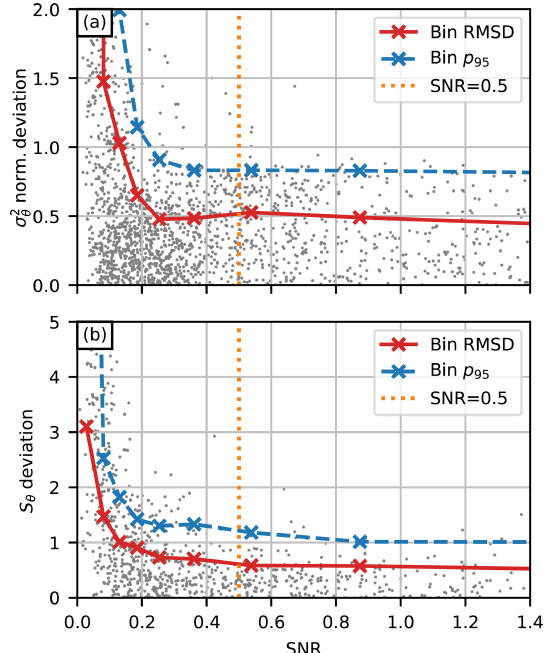
Figure 2. (a) Deviations of the DTS-estimated 30min potential temperature ( θ DTS ) from the corresponding mean reference po- tential temperature ( θ ref ) measured at an official weather station next to the measurement mast as a function of global radiation Q . The colour scale illustrates the relative marker density. (b) A violin plot of the same deviations for two groups of data: 30min accu- mulated liquid-phase precipitation P l < 0 . 1mm and P l ≥ 0 . 1mm. Violin bodies represent the data distributions, black whiskers show the 5th to 95th interpercentile ranges, and the red lines show the medians.